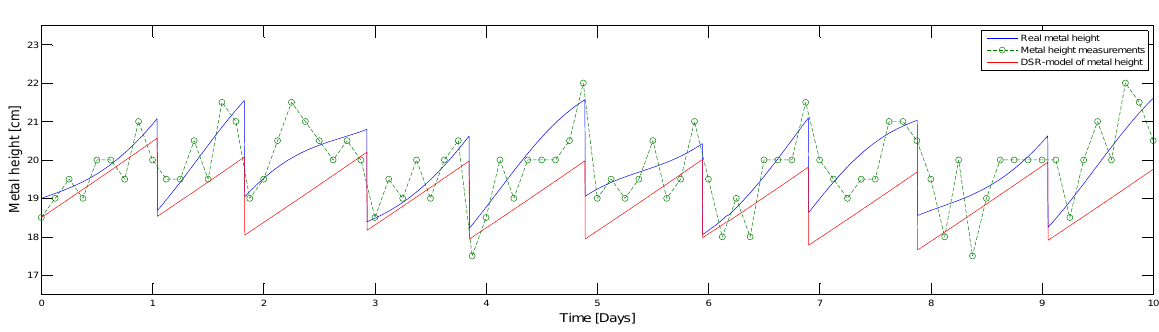
Figure 9: Prediction of the metal height, using DSR on the earlier synthetic data set. Unlike the assumed measurement regime for the OLS and ROLS models, the metal height is here assumed to be measured every 3rd hour. The noisy metal height measurements are shown with the green circles in the figure. In general, the simulated values are closer to the predicted than the measured